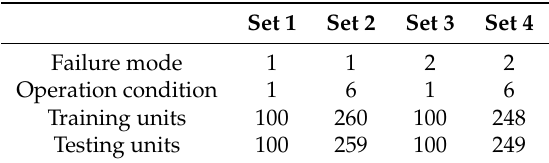
Table 2. Sensor data set description.